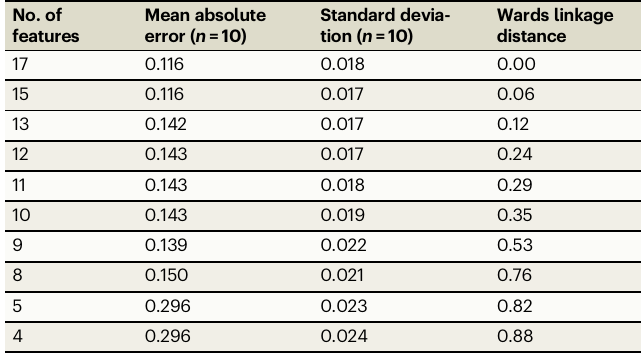
Table 2 | Table summarizes the impact of feature cluster removal (i.e., based on their respective linkage distances) on the predictive performance of the LGBM model No. of